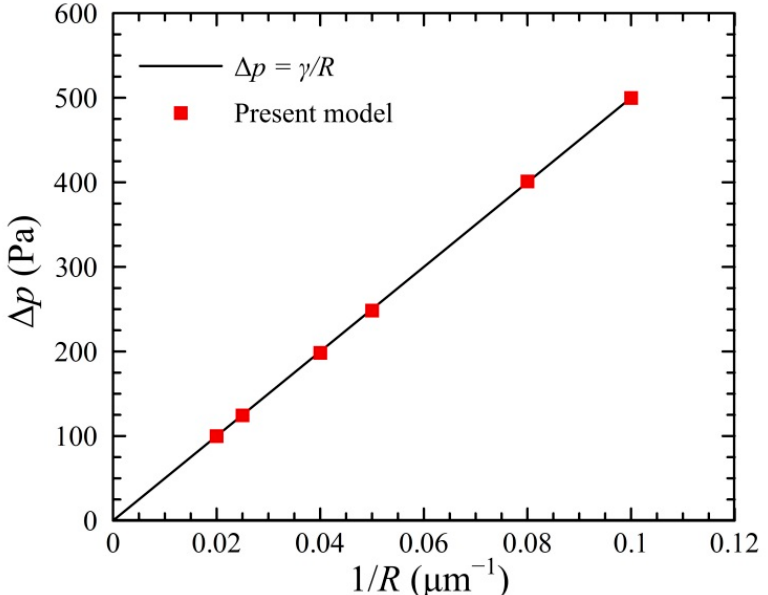
Figure 2. Numerical validation of Laplace’s law.